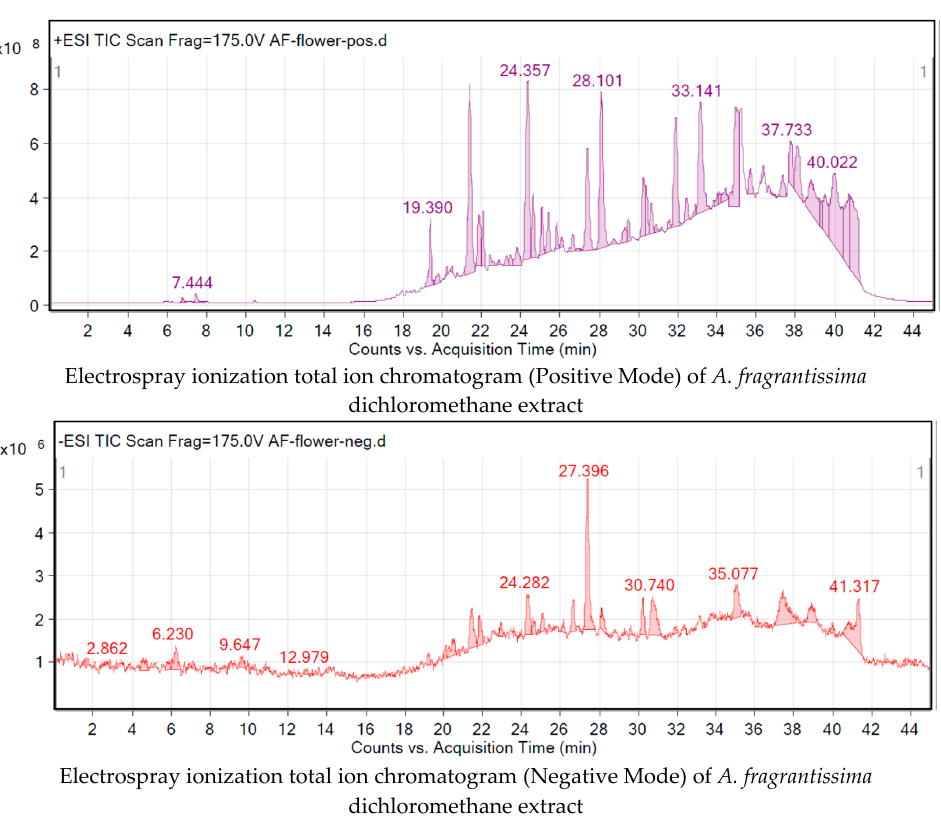
8 of 31 Figure 6. The increase in mitochondrial membrane potential opening activity in A. fragrantissima flower dichloromethane extract-treated TNBC MDA-MB-231 cells using confocal microscopy. The MDA-MB-231 cell treatment with A. fragrantissima flower dichloromethane extract (25–200 µg/mL) showed an increase in the activity of the opening of the mitochondrial transmission membrane pores, as indicated by the arrow. * p < 0.05 and ** p < 0.01 vs. DMSO-treated cells. 2.3. Metabolite Identification Using LC-QTOF The crude extract of the A. fragrantissima flower dichloromethane was subjected to total ion current (TIC) spectra raw data and the data analysis program MassHunter (Agilent Technologies) qualitative and quantitative analysis software was used. After conducting a mass screening on the below spectrum, chemical features were extracted from the liquid chromatography–mass spectrometry (LC-MS) data using the Molecular Features Extraction (MFE) algorithm and the recursive analysis workflow (Figure 7). Features were extracted by screening the detected nodes at various retention times (Rt)